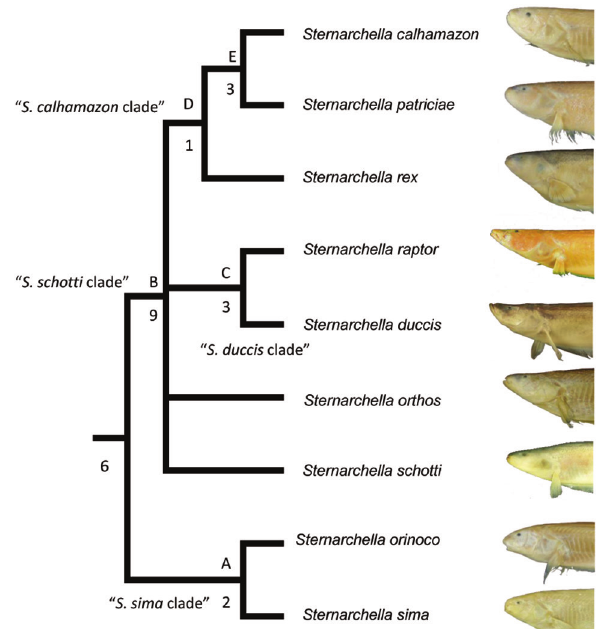
Fig. 5. Phylogenetic tree of Sternarchella resulting from a maximum parsimony analysis of the 76 morphological characters in Appendix 1 ( S1 - Available only as online supplementary file accessed with the online version of the article at http://www. scielo.br/ni). Bremer supports shown to the left of nodes. Clades labeled by letters and names as in text and Tab. 1.